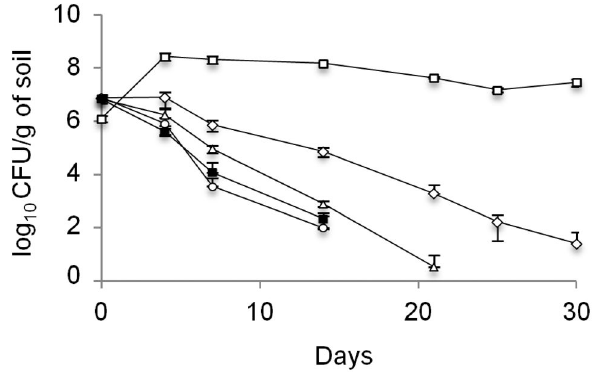
Figure 7. L. monocytogenes L9 survival over a 30-days period. In a natural soil (■), in the constructed soil microcosms with established undiluted (○), 10 2 - (Δ) and 10 4 -diluted ( ) microbiotas and in a γ-sterilised soil (□). The errors bars represent standard ◊ deviation from three replicate samples value.